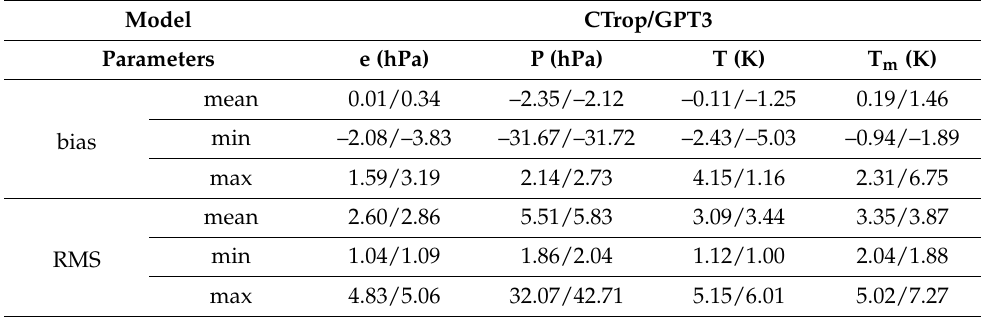
Table 1. Accuracy statistics of the meteorological parameters at each radiosonde site by the CTrop and GPT3